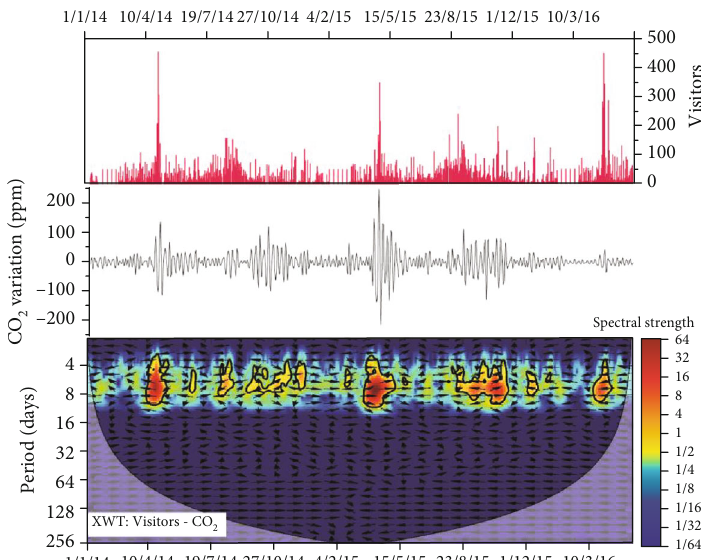
Figure 9: Energy across the multiresolution level corresponding to the 4-16 days of CO frequencies; spectral strength ranges from blue (weak) to red (strong) colors. Curved lines on the scalograms indicate the cone of in fl uence where the edge e ff ects are